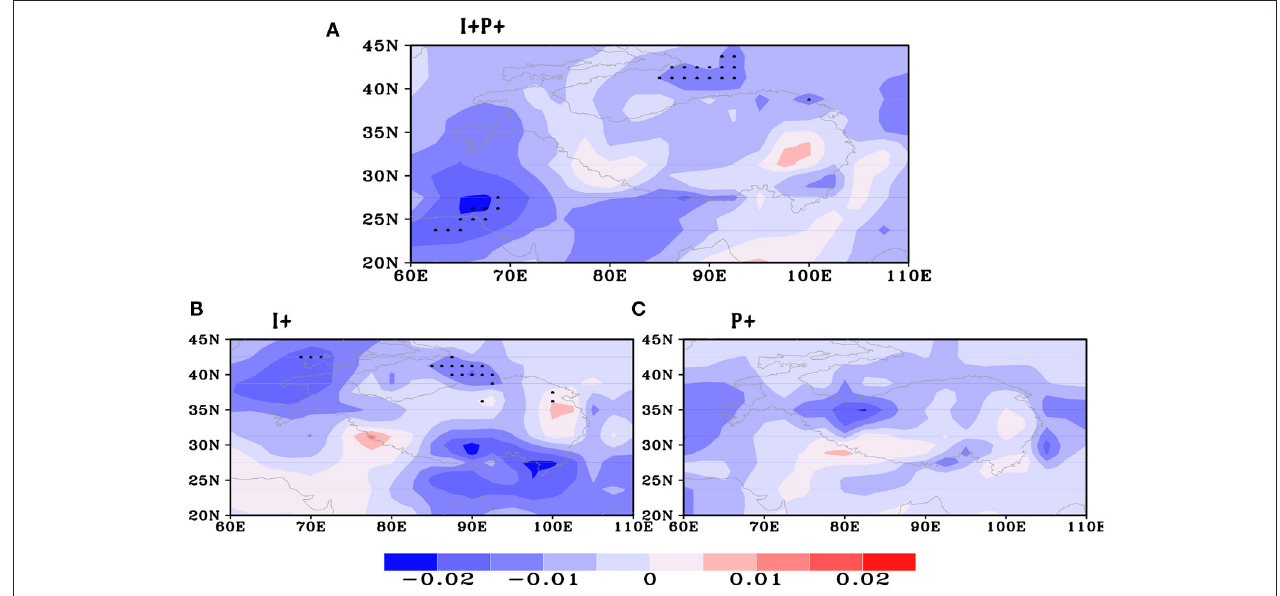
FIGURE 10 | As in Figure 8 , but for the 400-hPa vertical velocity anomaly field (m s − 1 ). Black dots indicate that the values exceeding the 95% confidence